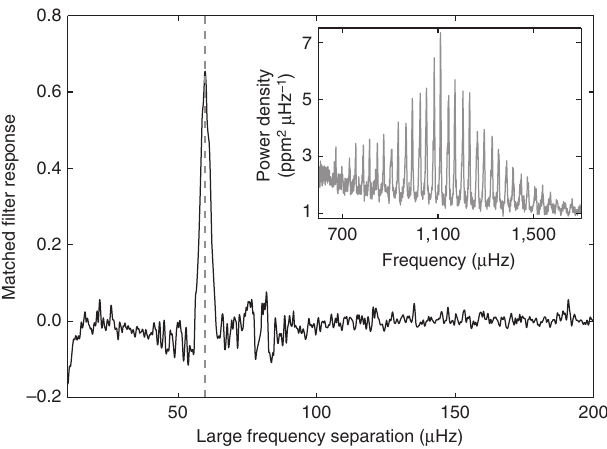
Figure 4 | The large frequency separation. Output from the matched filter response function for the host star KIC 9414417. The large peak seen at B 53 m Hz (and marked by the dashed line) indicates the large frequency separation for the star. The inset shows a section of the power spectrum of KIC 9414417 (smoothed with a Gaussian filter with a width of 1 m Hz), where the regular spacing between the oscillation frequencies is